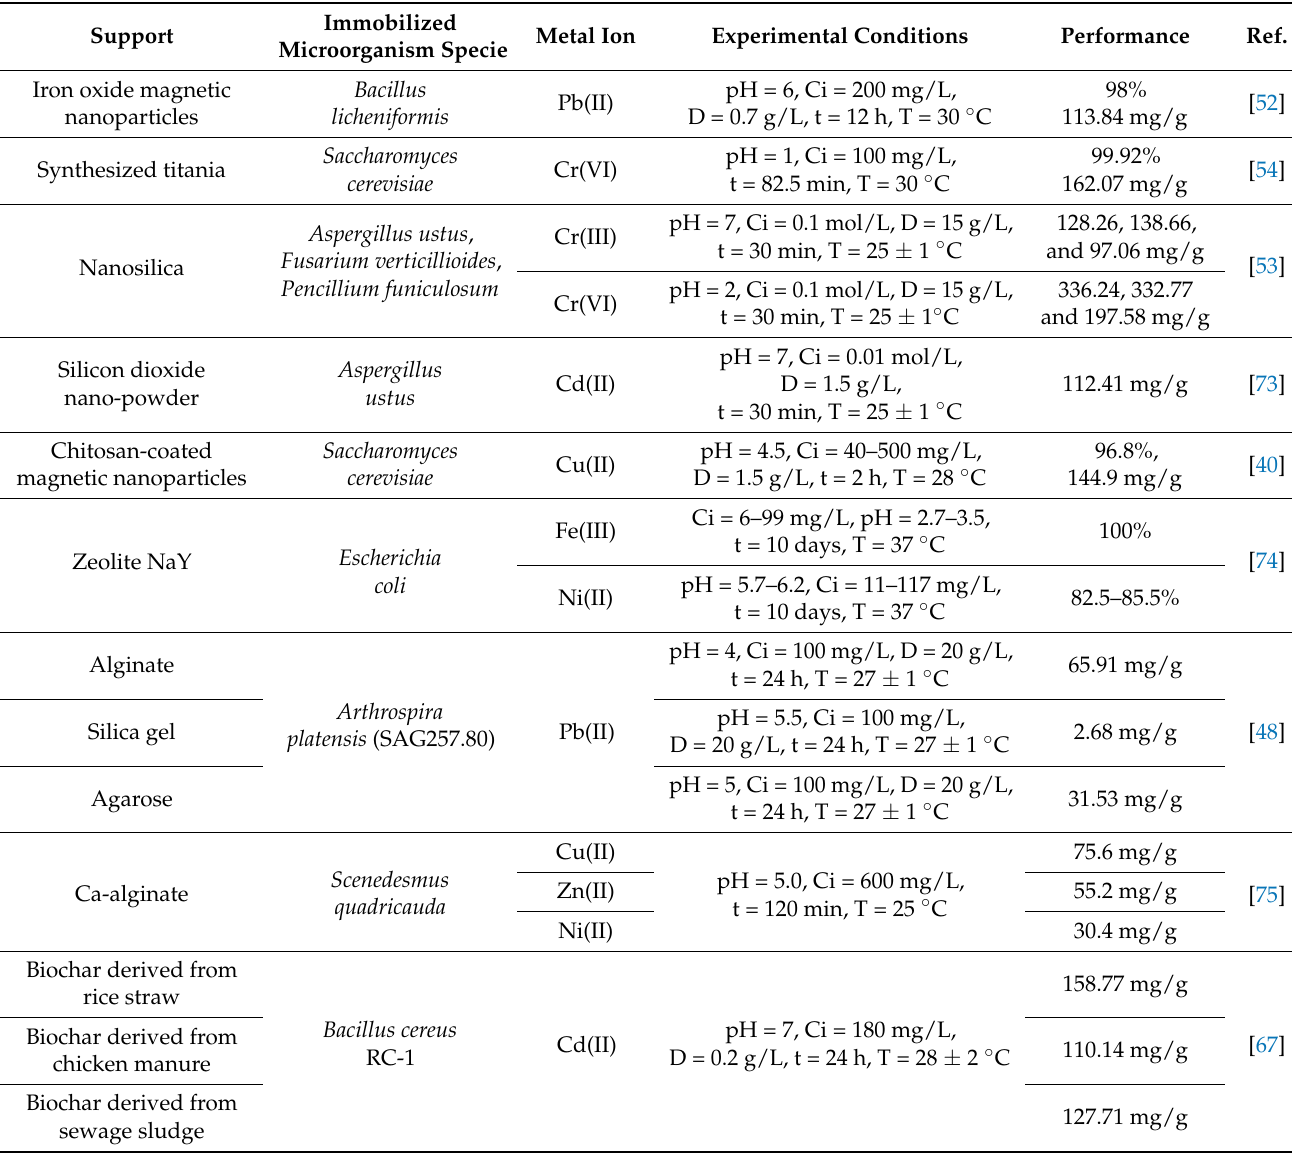
Table 1. Microbial cells immobilization on various supports and their performances for heavy metals removal in batch